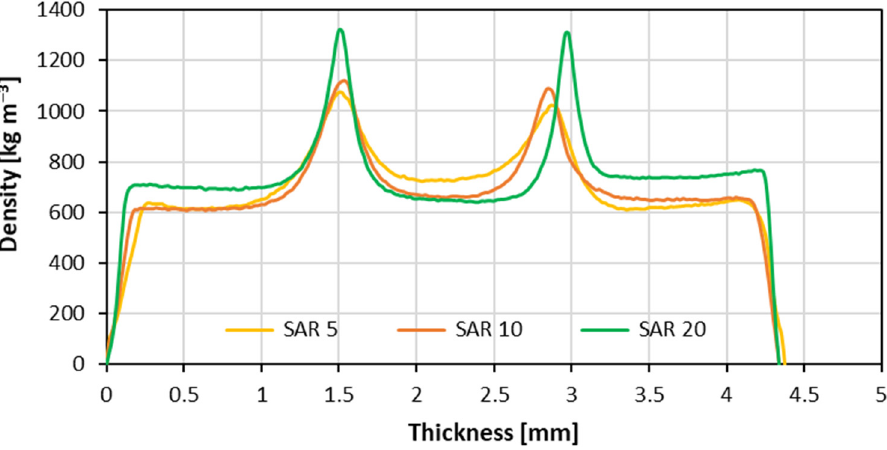
Figure 9. The density profiles of the plywood samples of different SAR filler content, hot-pressed.